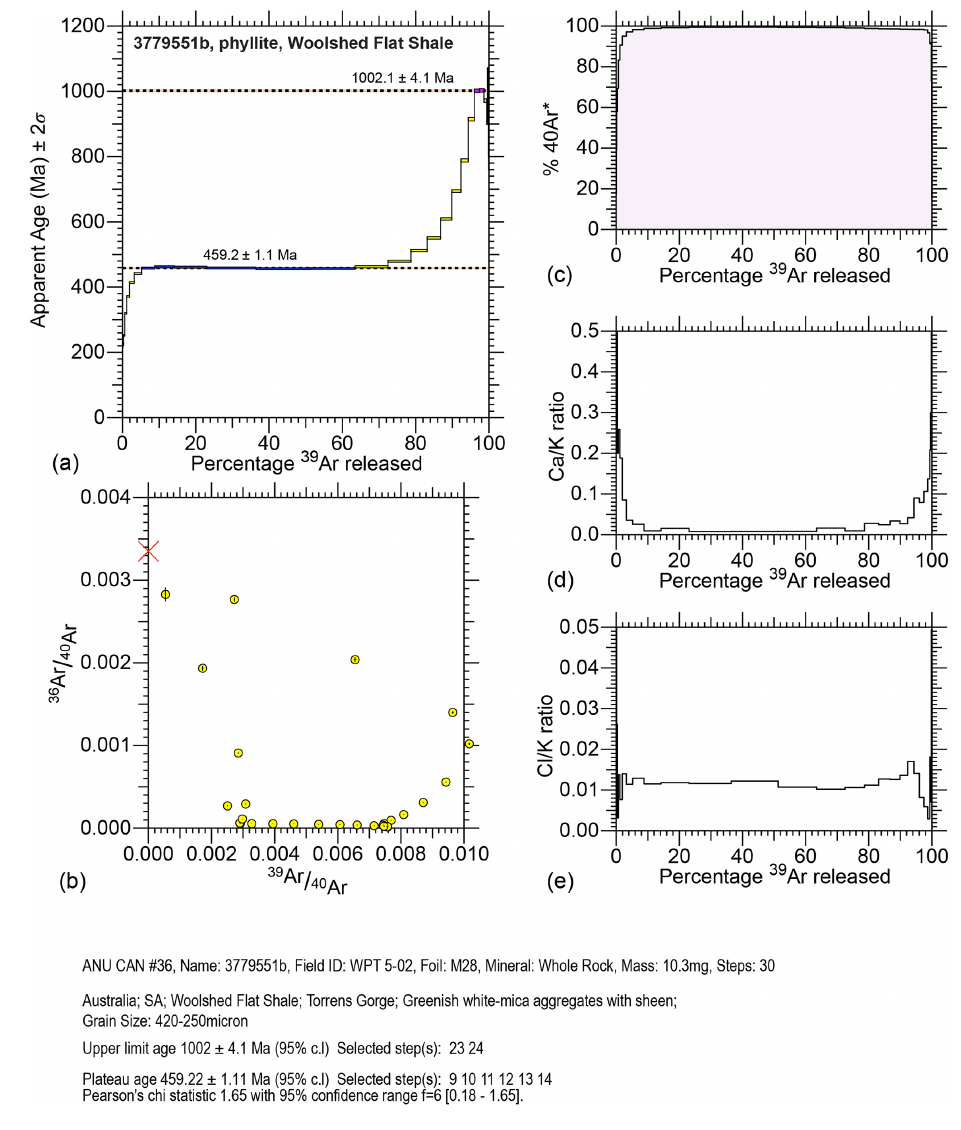
Figure C4. Sample 3779551b (a) age spectrum, (b) isotope correlation diagram, (c) percentage radiogenic 40 Ar ( 40 Ar ∗ ), (d) Ca / K ratio, and (e) Cl / K